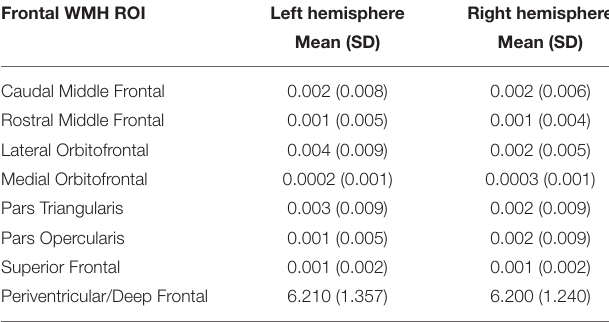
TABLE 3 | Average frontal WMH load by ROI. Frontal WMH